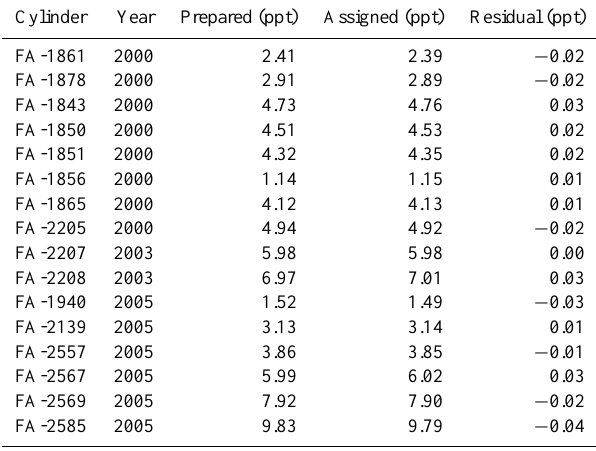
Table 2. Standards that define the NOAA-2006 SF 6 calibration scale.